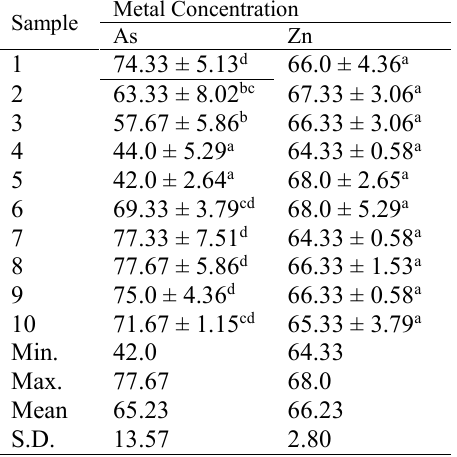
Table 1. Residual levels of examined elements in edible mushroom sample (mg/kg, dry weight)